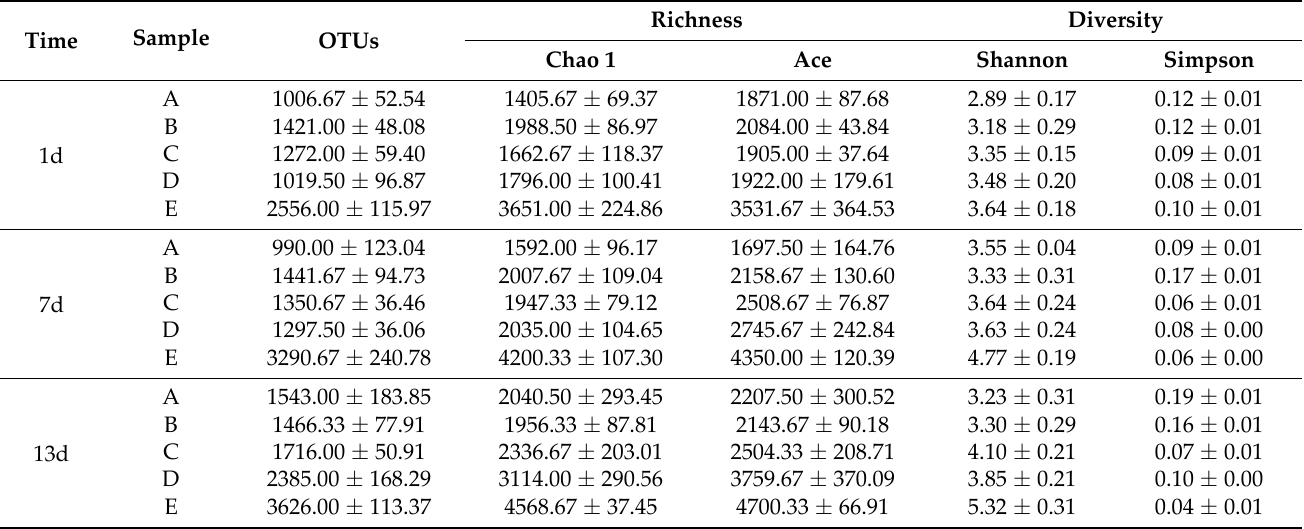
Table 3. The richness and diversity of the bacterial community from all treatments at different sam- pling times.